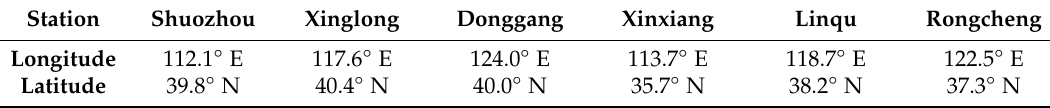
Table 1. Position of stations in the airglow observation